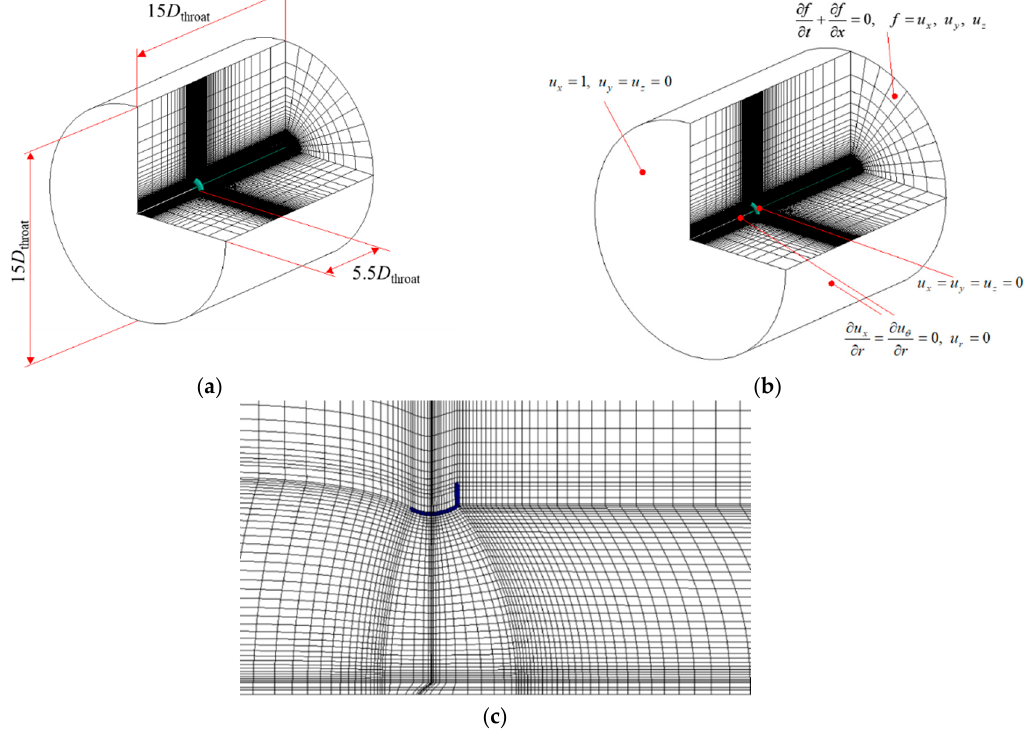
Figure 8. Computational grid and conditions: ( a ) The computational domain; ( b ) The boundary conditions; ( c ) The grid near the WLT (Ci05).